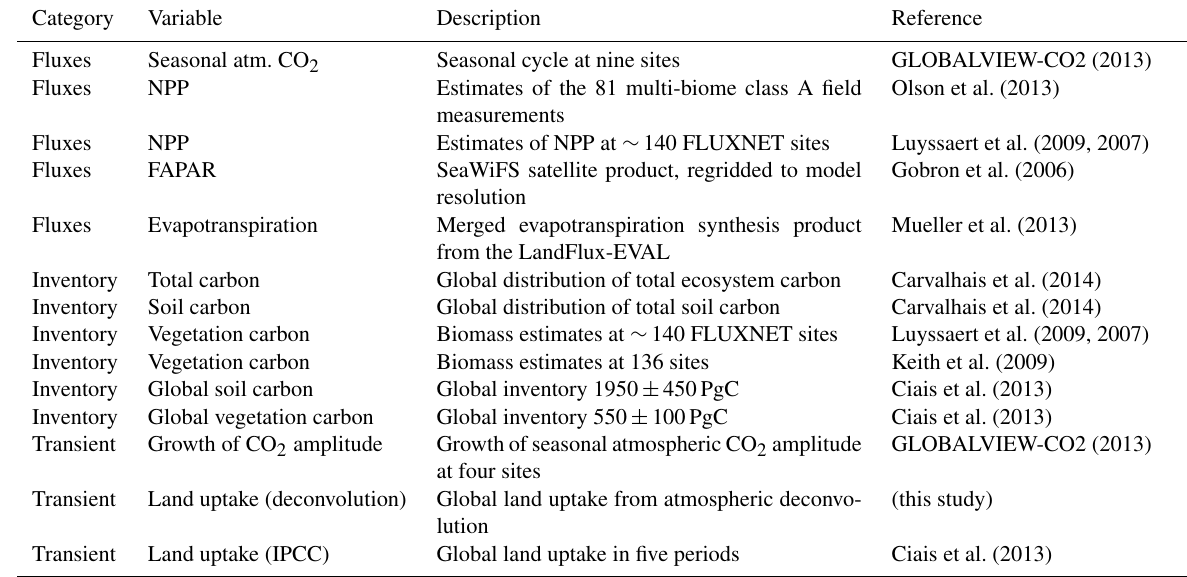
Figure 2. Hierarchical weighting scheme to aggregate the relative mean squared error of individual observational constraints to a total error which is then mapped to a total skill score. Table 2. Observations used to constrain the model